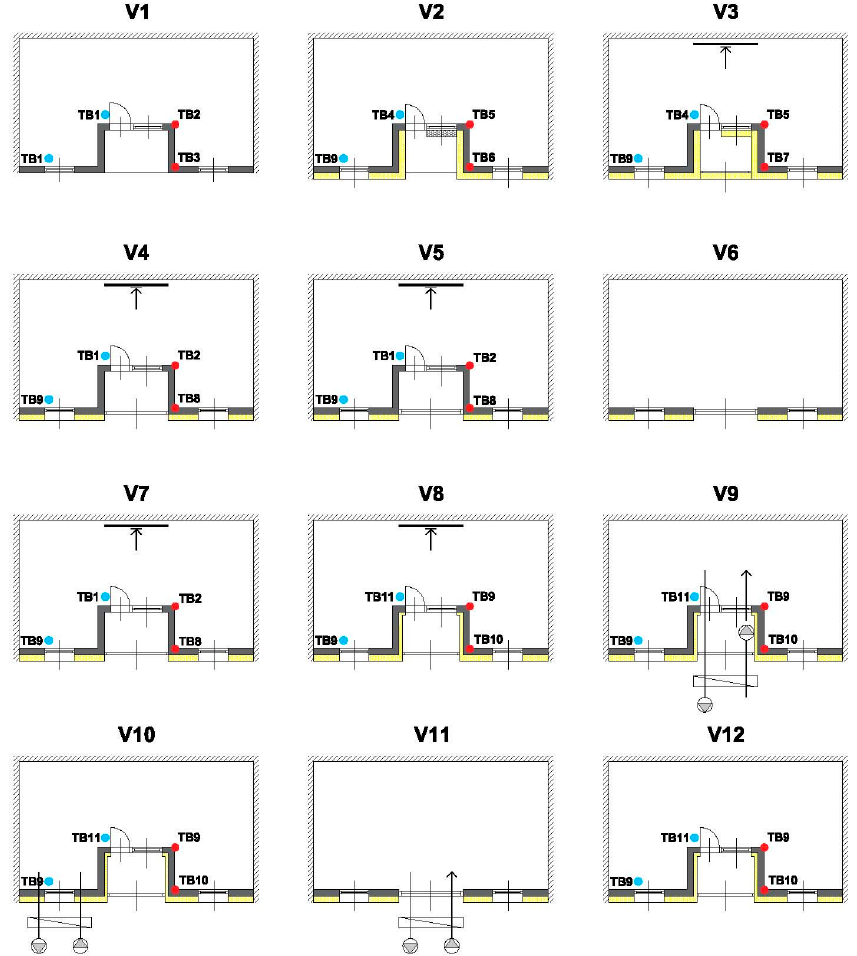
Figure 4. Scheme of the different veranda configuration evaluated, where yellow hatch is the thermal insulation, arrow is the mechanical ventilation (extraction), red circle is the corner thermal bridge, blue circle is the slab thermal bridge.